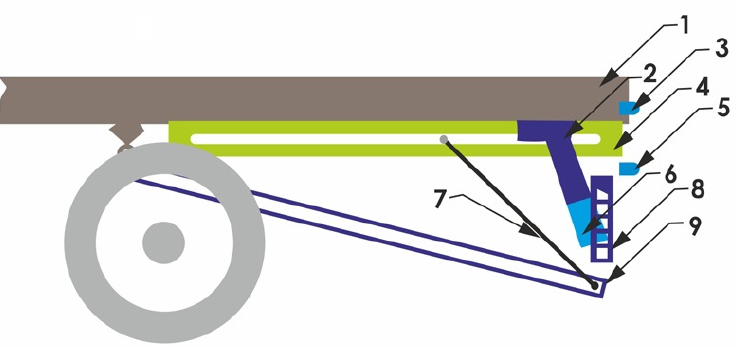
Figure 7. RUPD system for heavy goods vehicles. 1—Truck frame; 2—Support member fixed to the intermediate frame (4); 3—Speed sensor; 4—Intermediate frame of the system (support guide); 5—Distance sensor; 6—Support member fixed to the RUPD guard bar; 7—Lower platform holding-up ropes; 8—RUPD guard bar; 9—Lower platform.